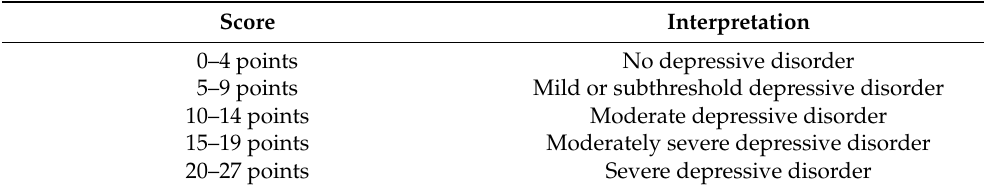
Table 2. Scores and their